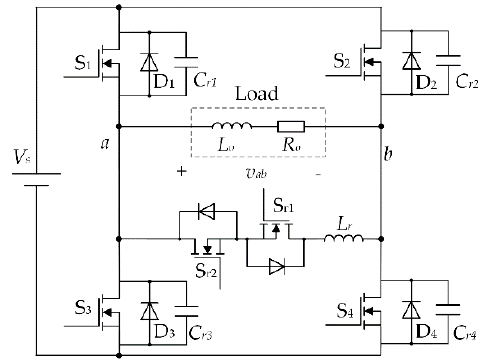
Figure 1. Circuit of auxiliary resonant snubber inverter.